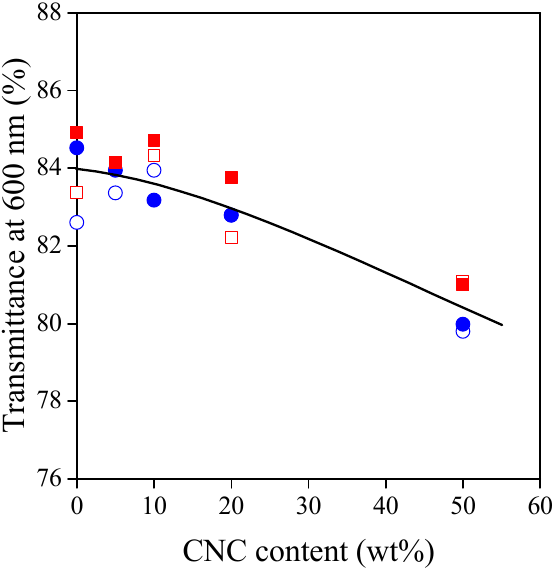
Figure 2. Transmittance of TPS–CNC composites at 600 nm as a function of CNC content. Symbols: ( ) 30% glycerol; ( ) 40% glycerol; ( ) 30% sorbitol; ( ) 40% sorbitol. The lower transmittance of TPS–CNC composites may originate from increased ab- sorbance or scattering, respectively. This latter is evidenced in Figure 3, in which Haze- indices follow the opposite tendency of transmittance. Furthermore, statistical analysis showed that the correlation between transmittance and haziness is extremely significant ( p = 3.39 × 10 –4 ). At any CNC content, the Haze index of the composites is determined mostly by the amount of the plasticizer. Higher plasticizer content results in less hazy materials due to the more homogeneous network of TPS and to the more homogeneous distribution of CNC particles.